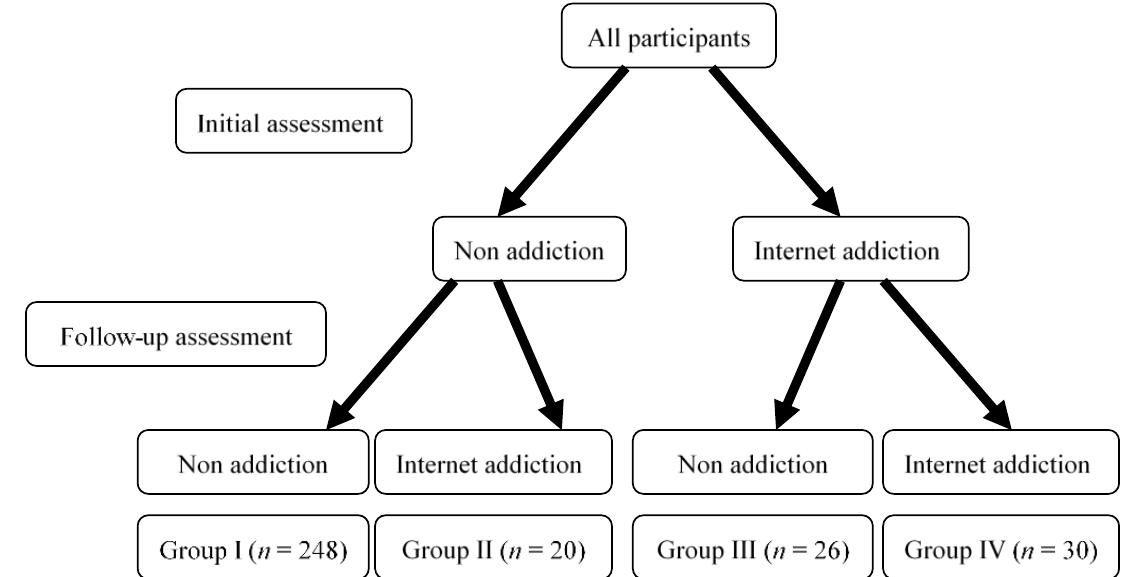
Figure 1. Participants in four groups with various statuses of internet addiction.